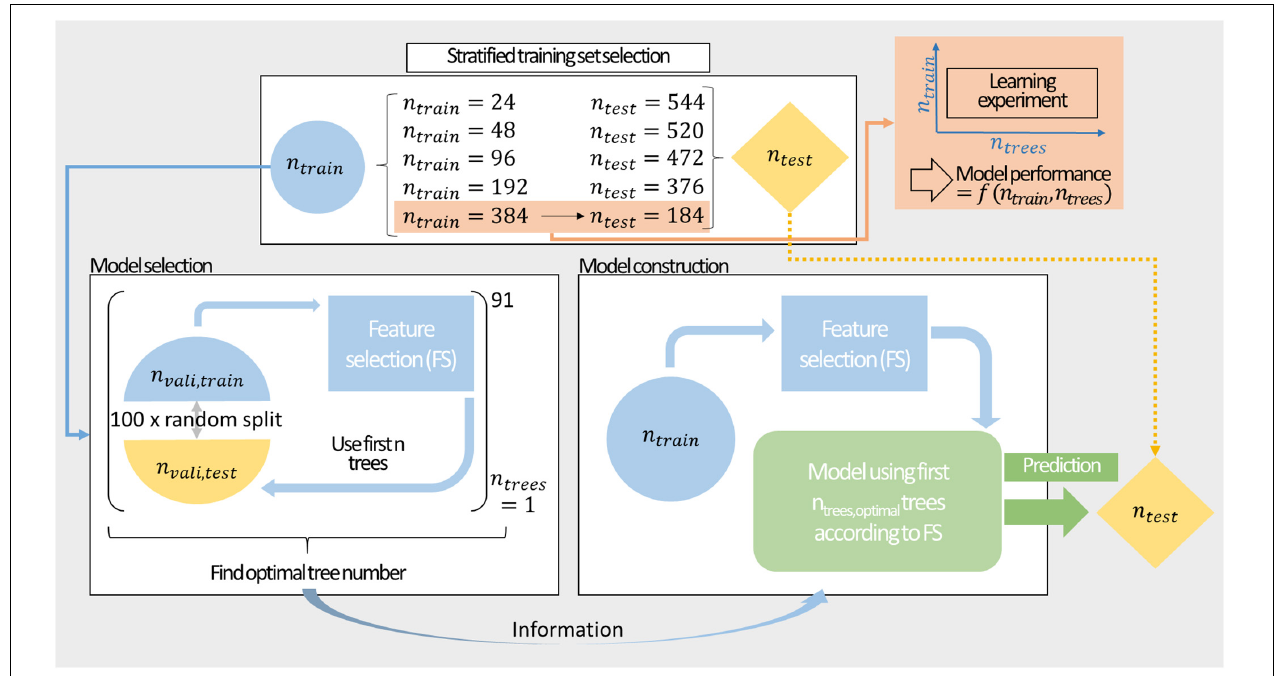
FIGURE 2 | Modeling workflow comprising stratified sampling, a learning experiment, model selection, and construction. Stratified sampling results in training sets of n train = { 24 , 48 , 96 , 192 , 384 } data points. These training sets are split in 100-fold Monte Carlo cross-validation to inform about the optimal number of classifiers. The training set is then used to construct a model with preceding feature selection to predict the external test set. The largest training set is additionally utilized for a learning experiment exploring the performance of the model in the space of training set size and number of included decision